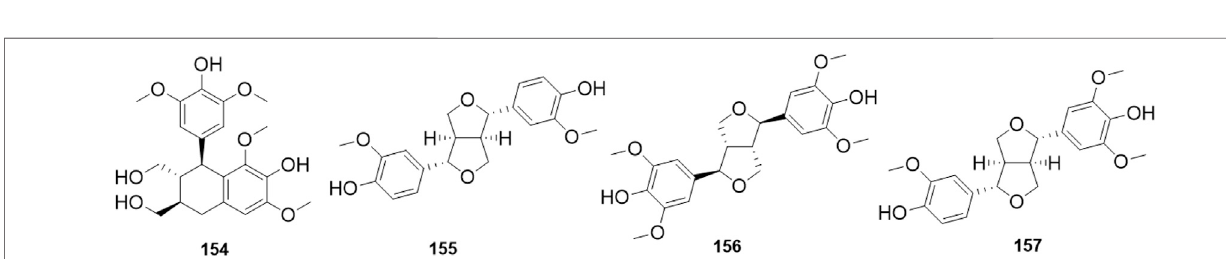
FIGURE 7 | Structures of the lignans (154 – 157) form P. mume .